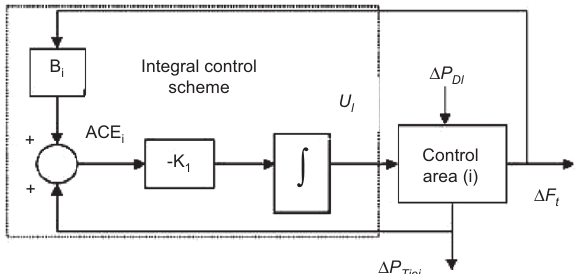
Figure 2. Conventional PI Controller Installed on the i th